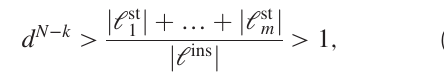
networks when D